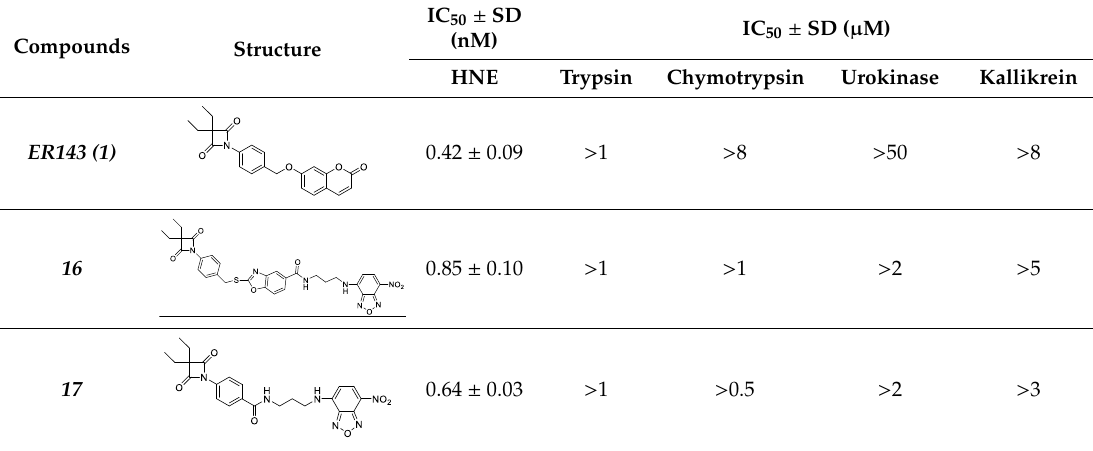
Table 3. Results of enzymatic inhibition and specificity assays for compounds 16 and 17 . Compound ER143 (1) was used as reference.